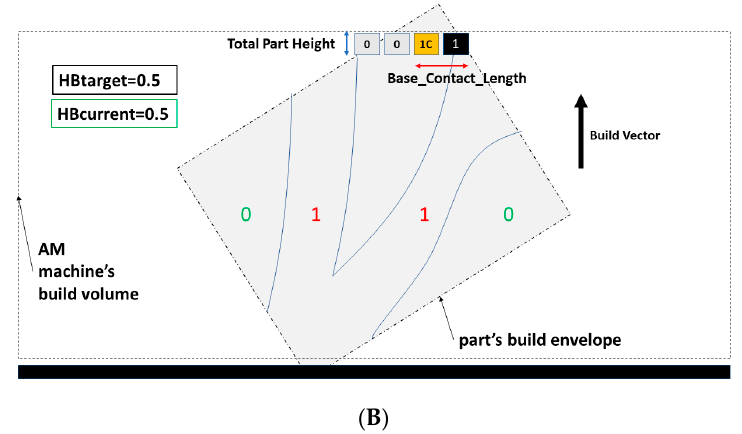
Figure 9. ( A ) First iteration with stressed elements that need to be part of the mass. ( B ) 1C elements are added to fulfill the HB ratio requirement.